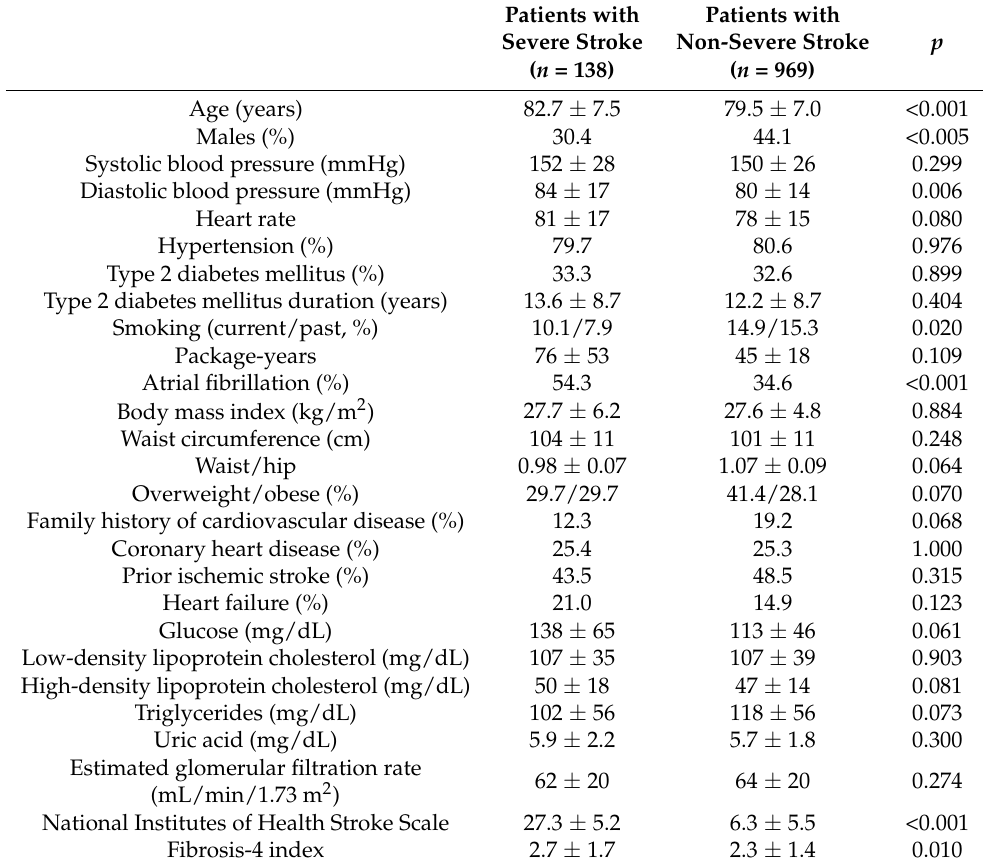
Table 1. Patients’ characteristics at admission stratified according to stroke severity ( n =